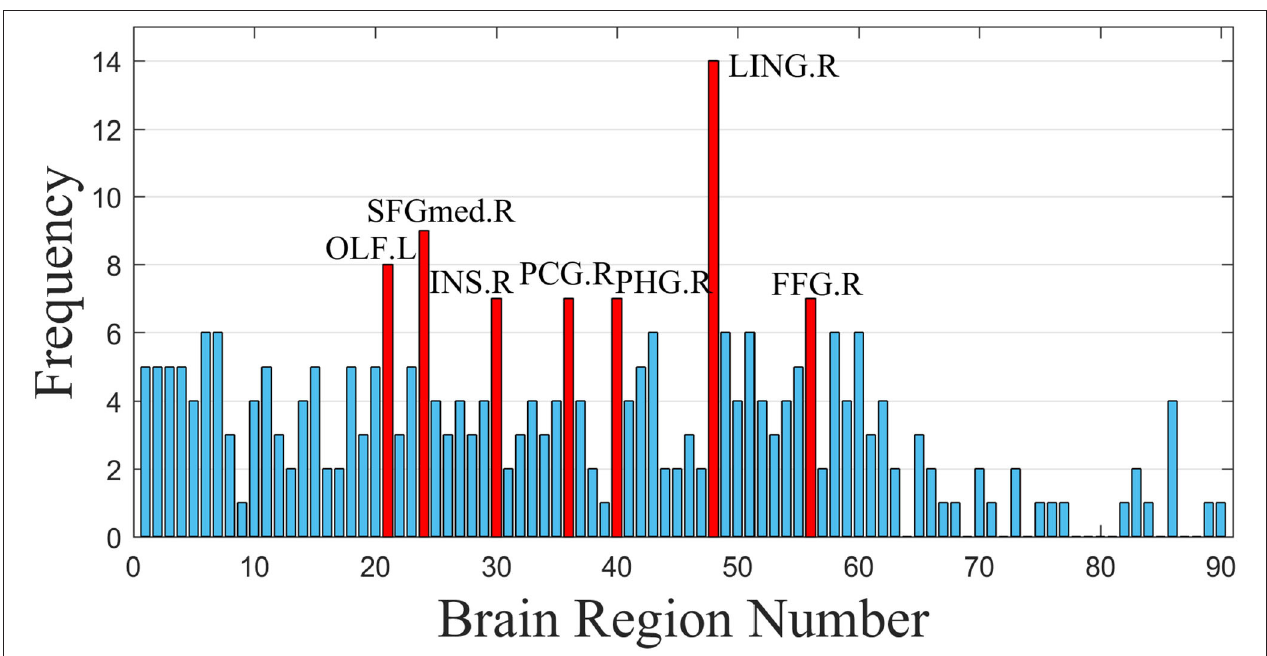
FIGURE 7 | Frequencies of all